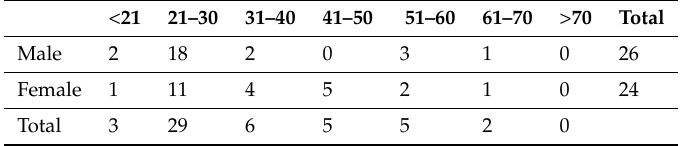
Table 23. Demographics of users who had suffered ID theft and account